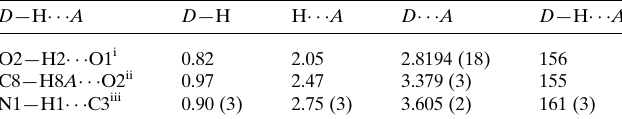
Table 1 Hydrogen-bond geometry (A˚ , (cid:2) ).